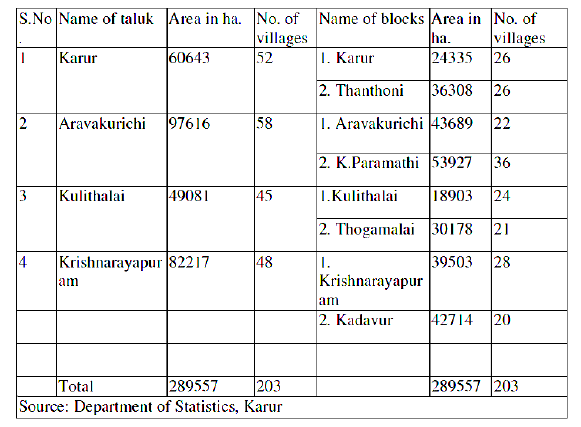
Table 3: Karur Taluk and Block